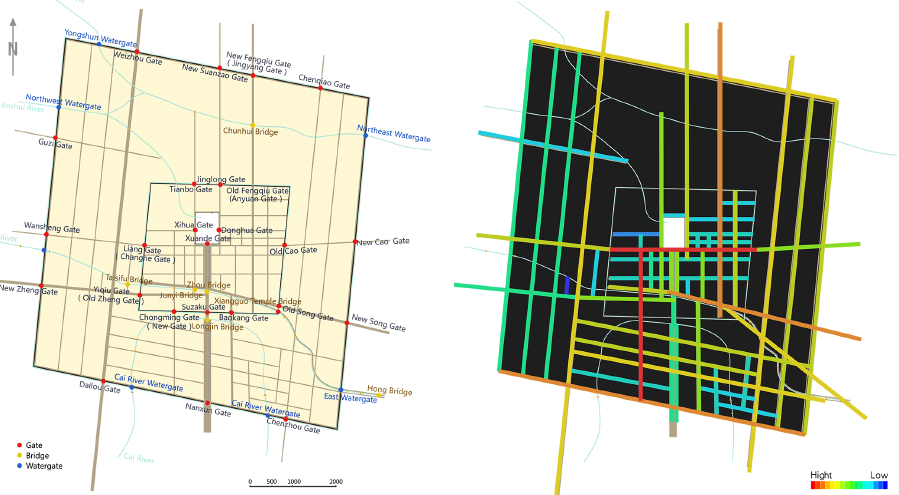
Figure 4. Global integration value of the axes in Dongjing of the Song Dynasty. The global integration degree calculation was affected by the incomplete archaeo- logical and documentary data on both cities. Therefore, the local integration degree was applied for supplementary analysis. Local integration (radius = 3) reflects pedestrian movement. Before the analysis, it was necessary to verify the urban space’s local and global coordination through the synergy ratio. Synergy is the correlation value between the global integration value (radius = n) and the local integration value (radius = 3). It describes whether the local and global accessibility of the axes are consistent. Axial systems